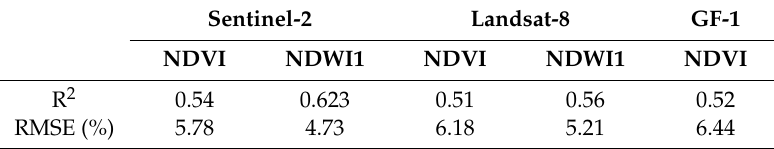
Figure 6. Scatter plot between the value of soil moisture retrieval and the value of measured soil moisture. Table 7. Statistical parameters of soil moisture retrieval with di ff erent optical data Table 7. Statistical parameters of soil moisture retrieval with different optical data indices.